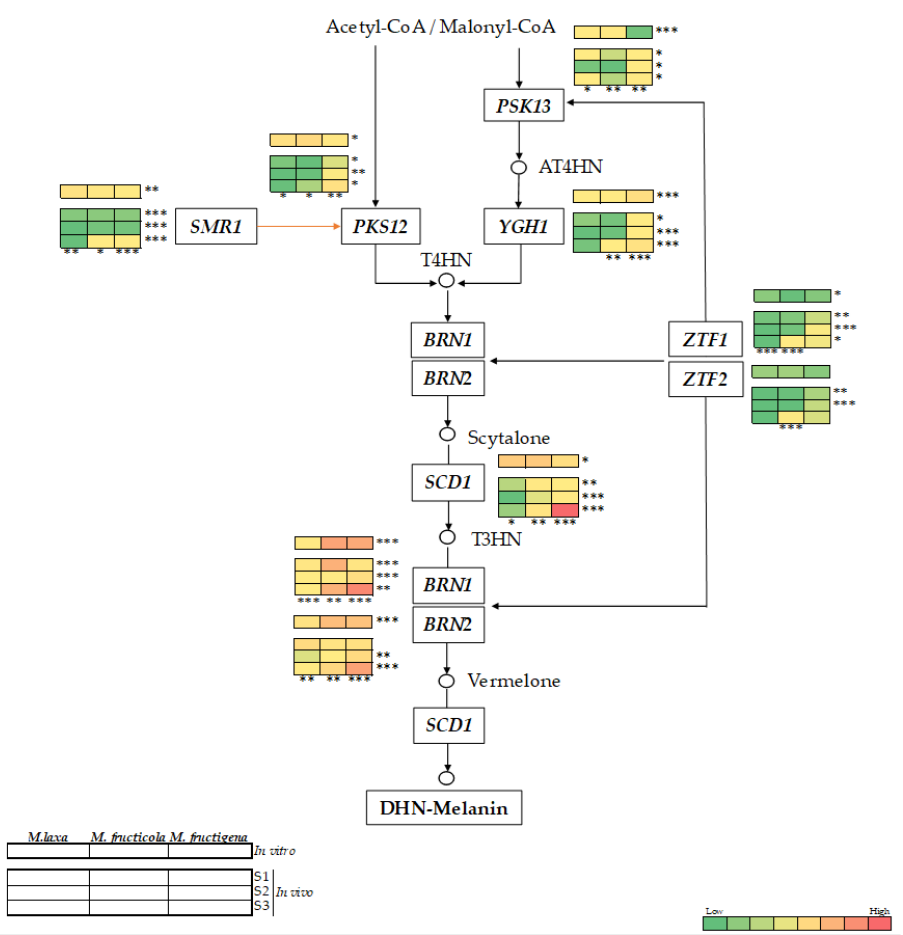
Figure 5. Putative DHN-melanin biosynthesis pathway of Monilinia spp. Black arrows indicate conserved steps between species, while the orange arrow indicates a possible difference between species. Heat maps represent the relative gene expression of each gene of the pathway for both in vitro conditions and in inoculated ‘Red Jim’ nectarines at three stages of brown rot development (S1: peel surface maceration stage; S2: colonization stage; and S3: spreading stage). The color of the heat map represents the relative gene expression intensity. For each gene, the asterisks indicate significant differences among species (right) for in vitro conditions, among species for each stage (right) and among stages for each species (bottom) in nectarines (* p < 0.05; ** p < 0.01; *** p